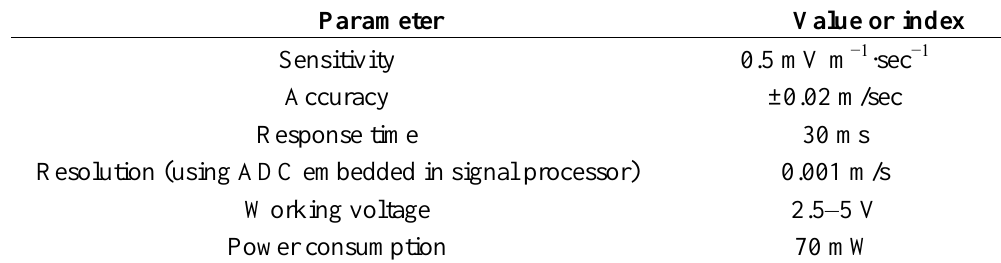
Table 5. Parameters of the flow sensor